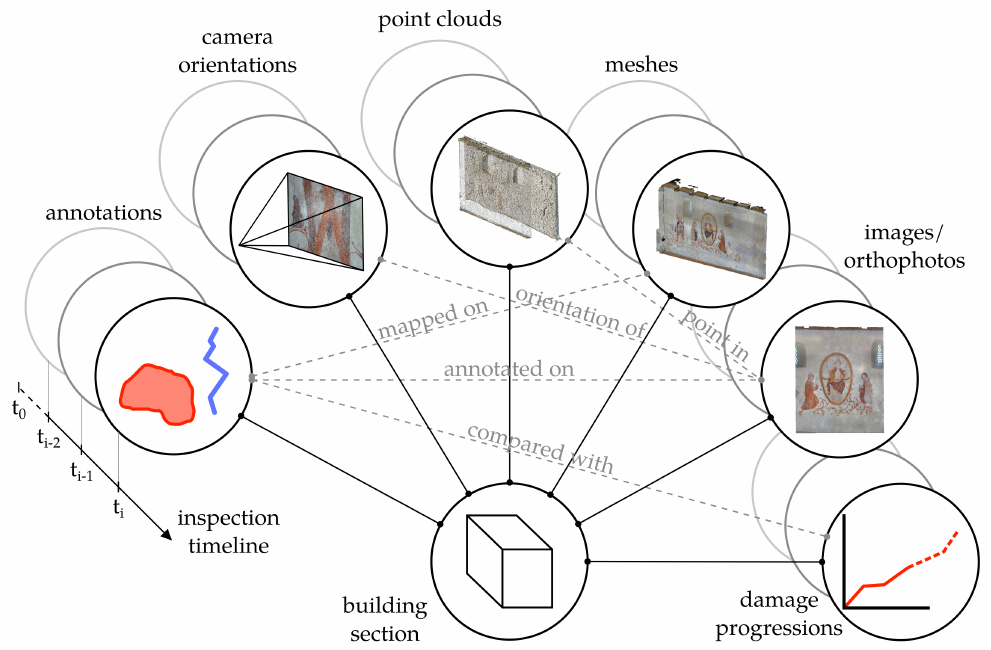
Figure 9. Schema of the linking between the different data entities in the case study to achieve a comprehensive condition history on the inspection